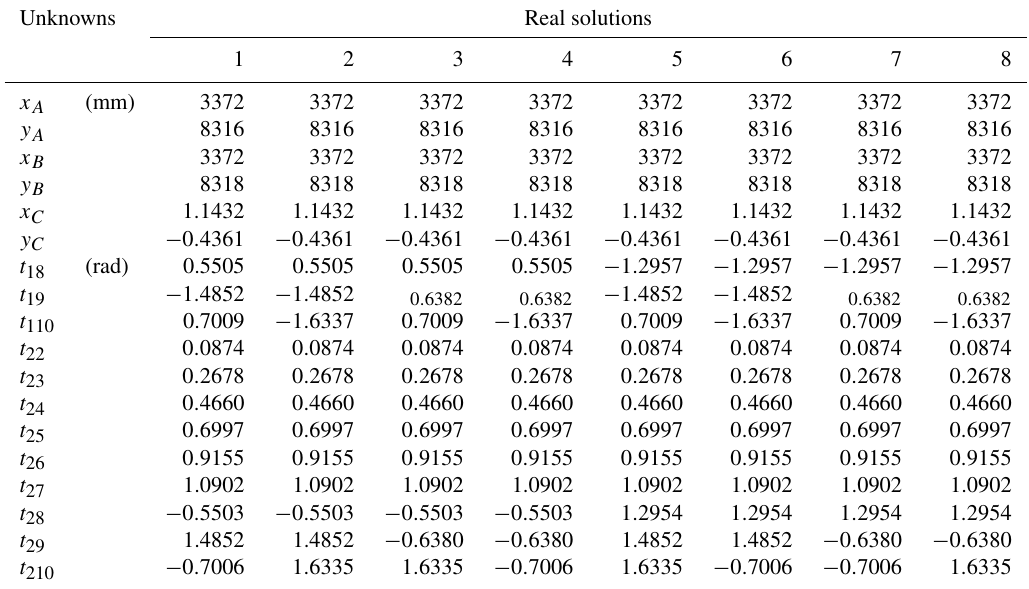
Table A4. Real solutions